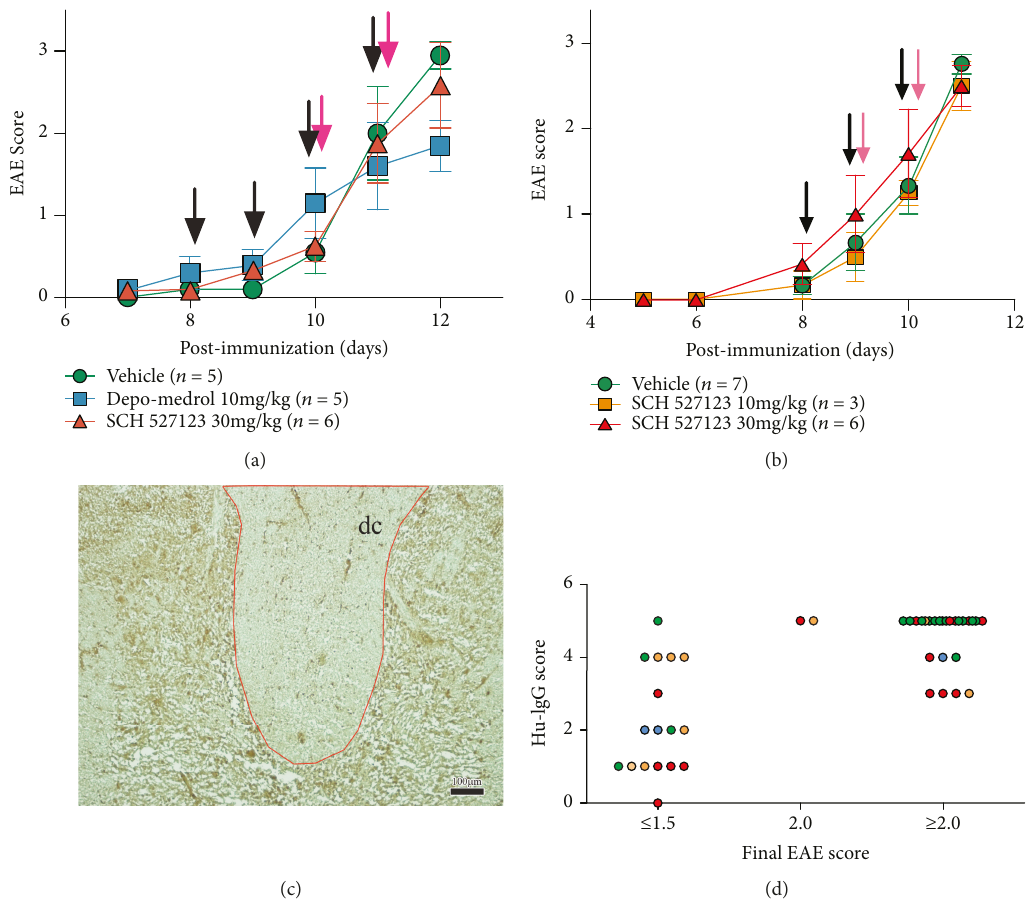
Figure 1: (a, b) After immunizing Lewis rats with gpMBP to induce EAE, CXCR2 antagonist (red triangles) or vehicle control (green circles) was injected at the time points indicated by the black arrows and pooled IgG from AQP4-seropositive NMO patients was injected at the time points indicated by the pink arrows. Treatment with corticosteroid, Depo-Medrol, on days 8 and 10 was included in cohort 1 ((a) blue squares), while cohort 2 tested SCH527123 at both 10mg/kg (orange squares) and 30 mg/kg (red triangles). EAE scores were not exacerbated by IgG from AQP4-seropositive NMO patients. (c) Di ff usion of human IgG (Hu-IgG) into the spinal cord was assessed by immunohistochemistry (brown stain) and scored semiquantitatively. (d) Human IgG (Hu-IgG) was associated with higher EAE scores, while lower EAE scores were associated with lower levels of human IgG signal in the spinal cord.